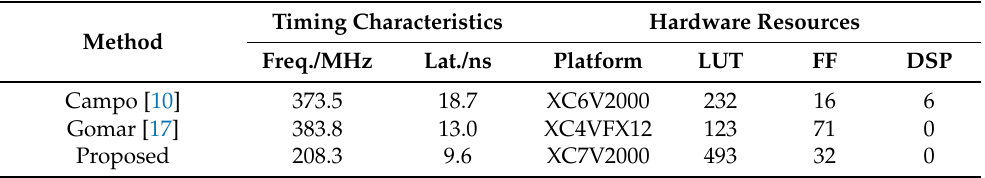
Table 5. Timing characteristics and hardware resources of different methods.